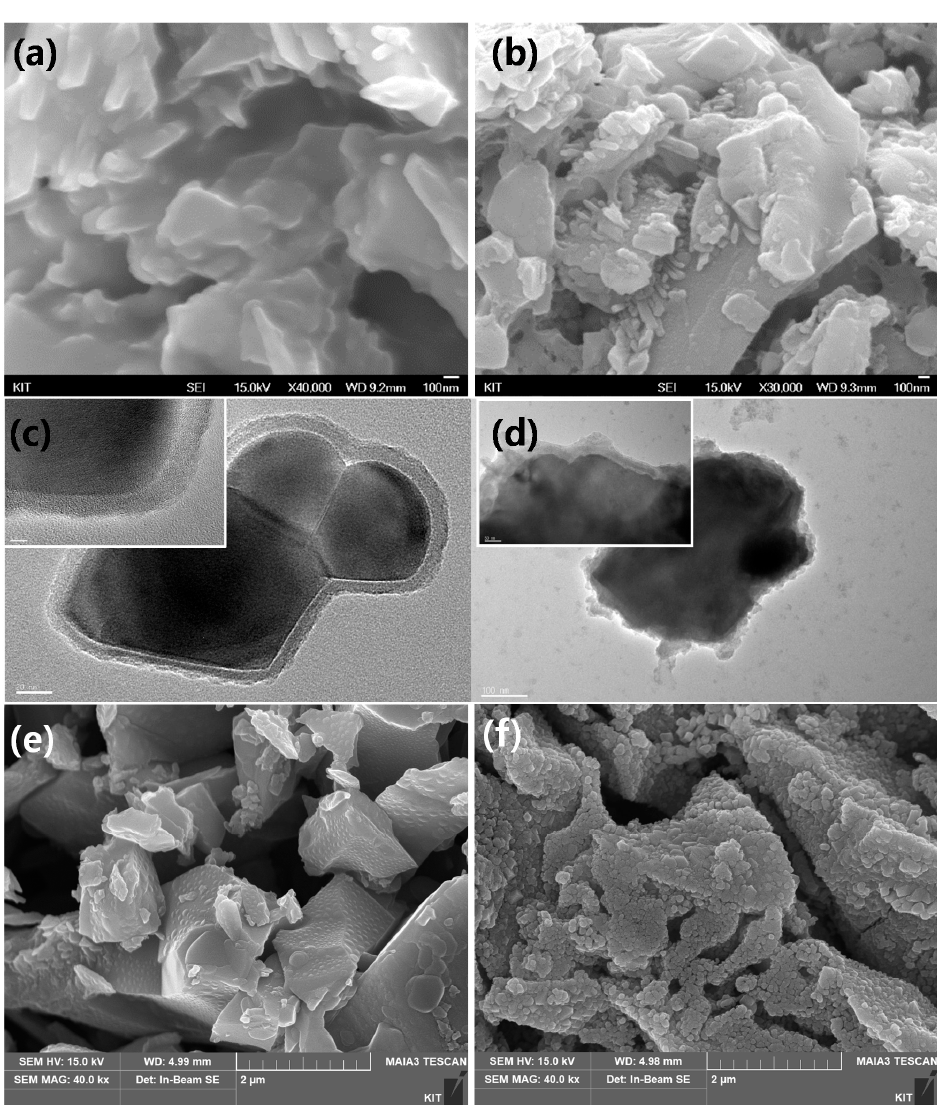
Figure 3. Scanning electron microscope (SEM) and transmission electron microscope (TEM) images of the cathode layer composites of FeS 2 /PIS: ( a , c ) after formation of the cathode composites at 250 ◦ C; ( b , d ) after a 1 h treatment at 450 ◦ C. SEM images of pellet-type FeS 2 : ( e ) after formation of the cathode; ( f ) after a 1 h treatment at 450 ◦